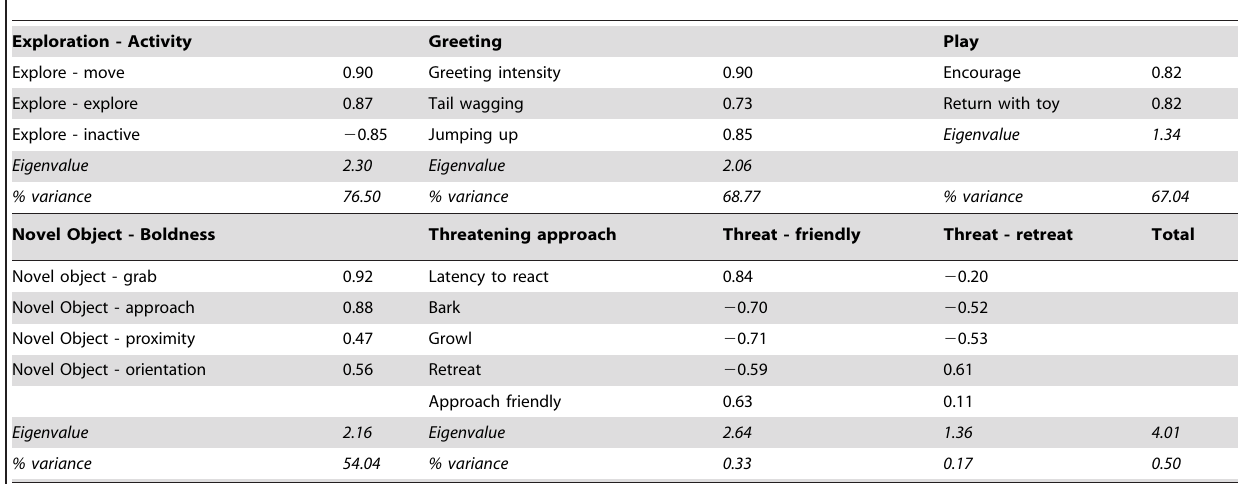
Table 9. Components and component loadings of CATPCA over selected variables from the adult test.